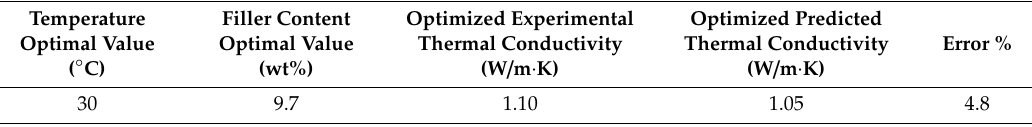
Table 5. Experimental validation of predicted thermal conductivity response of the nanocomposites based on the predicted optimal conditions of temperature and magnetic